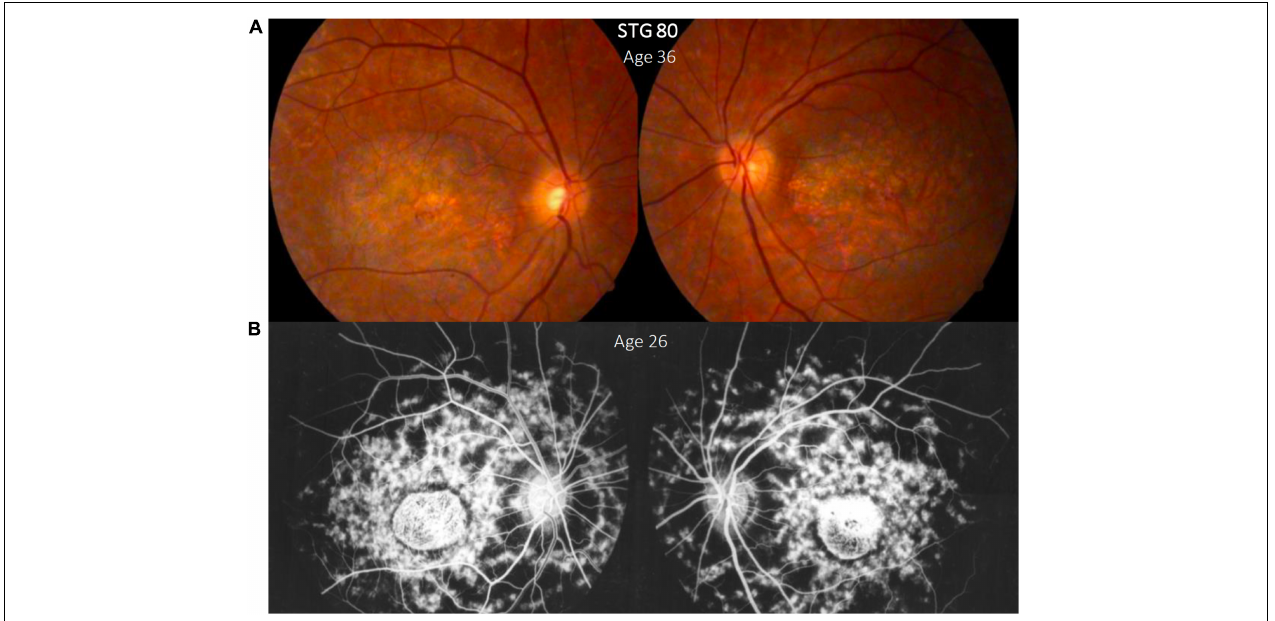
FIGURE 2 | Clinical presentation in patient STG 80, (A) Color fundus photographs (RG) of both eyes with macular atrophy and peripheral flecks (fundus grade: 3b) (B) fluorescein angiography images (FA) clearly show dark “silent” choroid and central hyperfluorescence due to macular atrophy in this angiogram that was made years before our assessment. Note the enlargement of the diameter of the macular atrophy between the FA image brought by the patient (B) and the color RG (A) taken years later for this